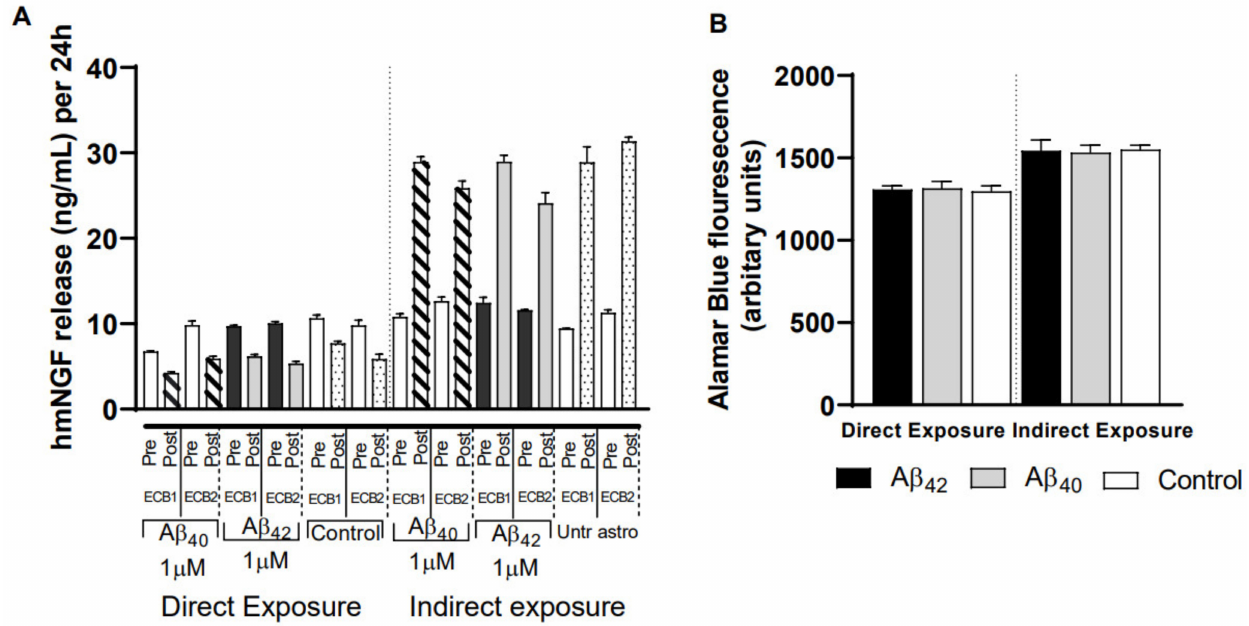
Figure 6. A β 40/42 peptides and ACM differentially regulate hmNGF release from ECB devices. ECB devices were maintained in DMEM/F12 media for few weeks before exposing them to A β 40/42 peptides (1 µ M) or ACM (treated with 1 µ M A β 40/42 peptide) for 7 days in a final volume of 1 mL. ( A ) Following 7 days of exposure, media was replaced with 1 mL of fresh DMEM/F12, and ECB devices were further incubated for 4 h. The amount of hmNGF released during this 4 h was measured using ELISA (R & D Systems) by withdrawing 500 µ L of media. The values obtained were multiplied by a factor of 6 to convert data to hmNGF released over 24 h. Data from individual ECB devices are represented. ( B ) To measure the impact of the exposure on metabolic activity, 1 × alamarBlue was added and incubated for 1 h. In total, 100 µ L of medium were drawn in triplicates and fluorescence was measured at 540/590 nm in a Tecan plate reader using a black bottom 96-well plate. Data are represented as mean ± S.E. ( n =